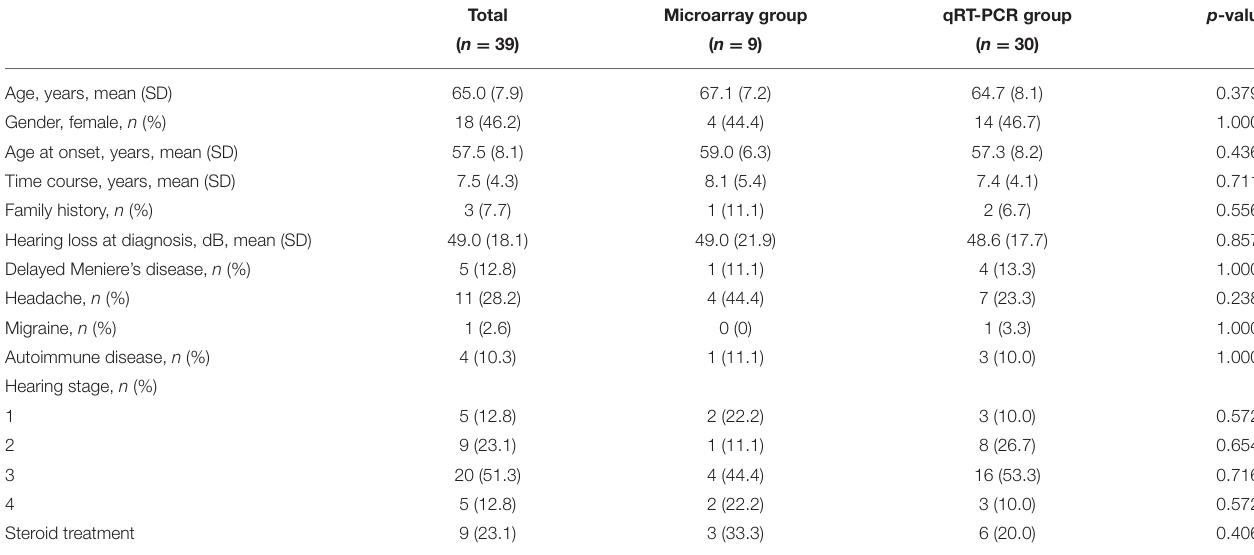
TABLE 1 | Demographic and clinical characteristics of patients with the Meniere’s disease